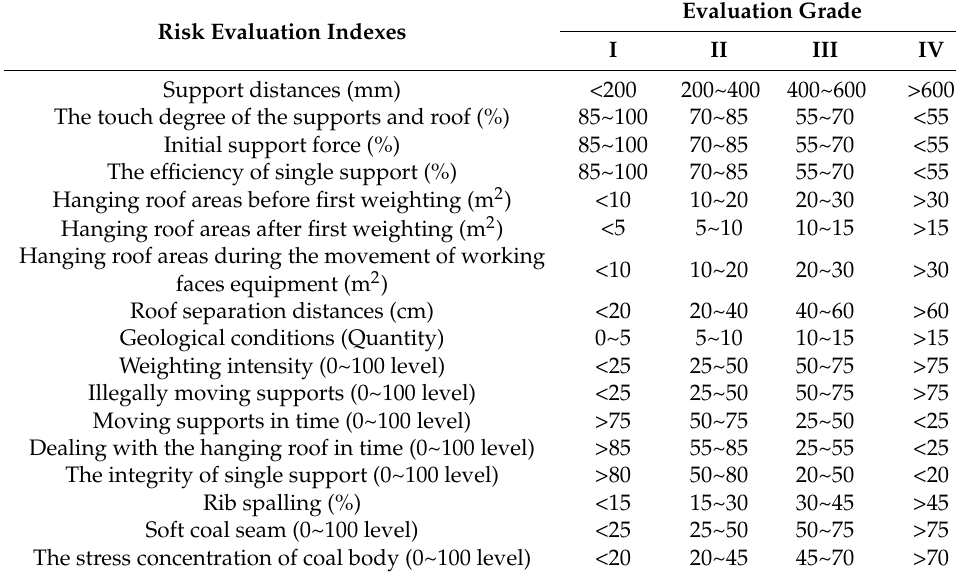
Table 3. Risk evaluation grade standard of roof accidents.